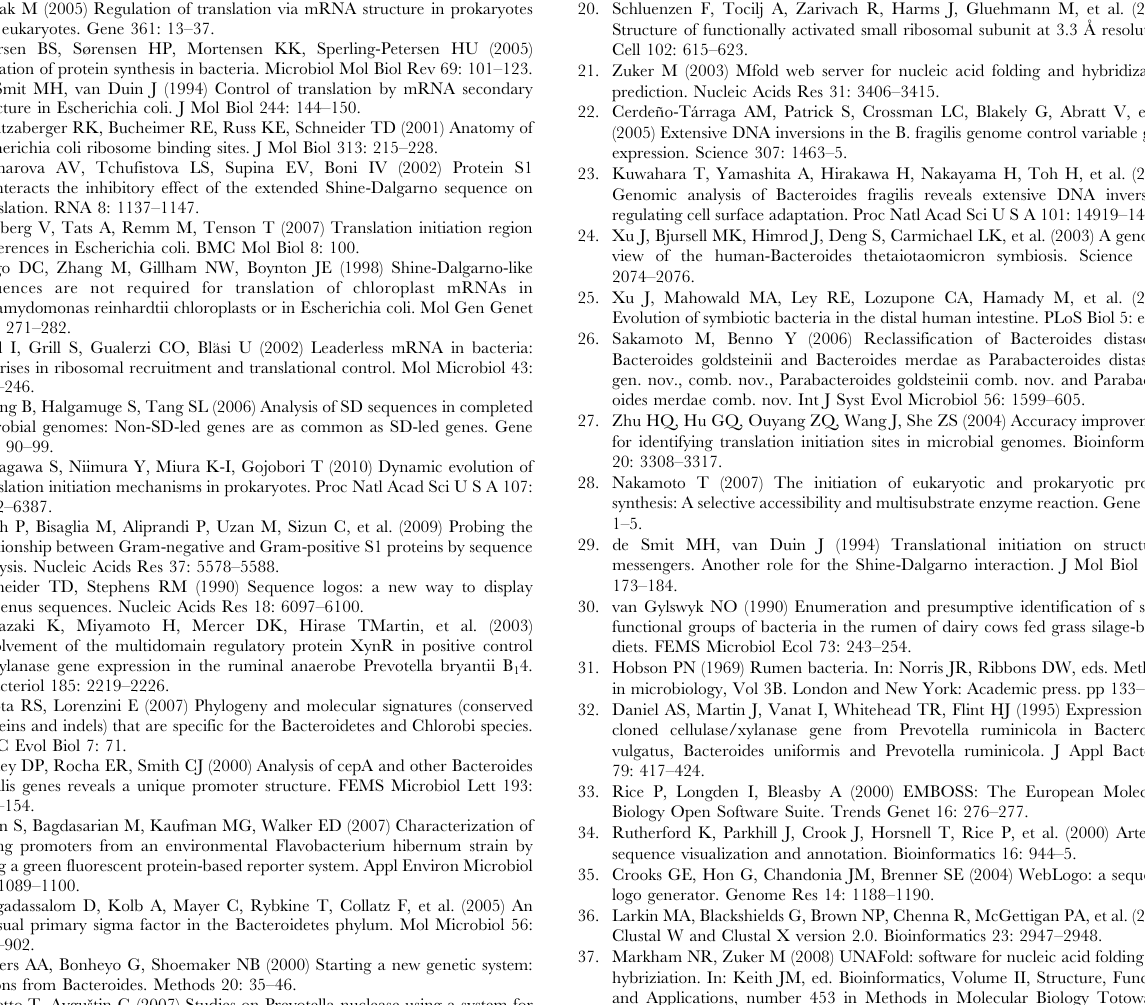
Table S3 Primers used in the